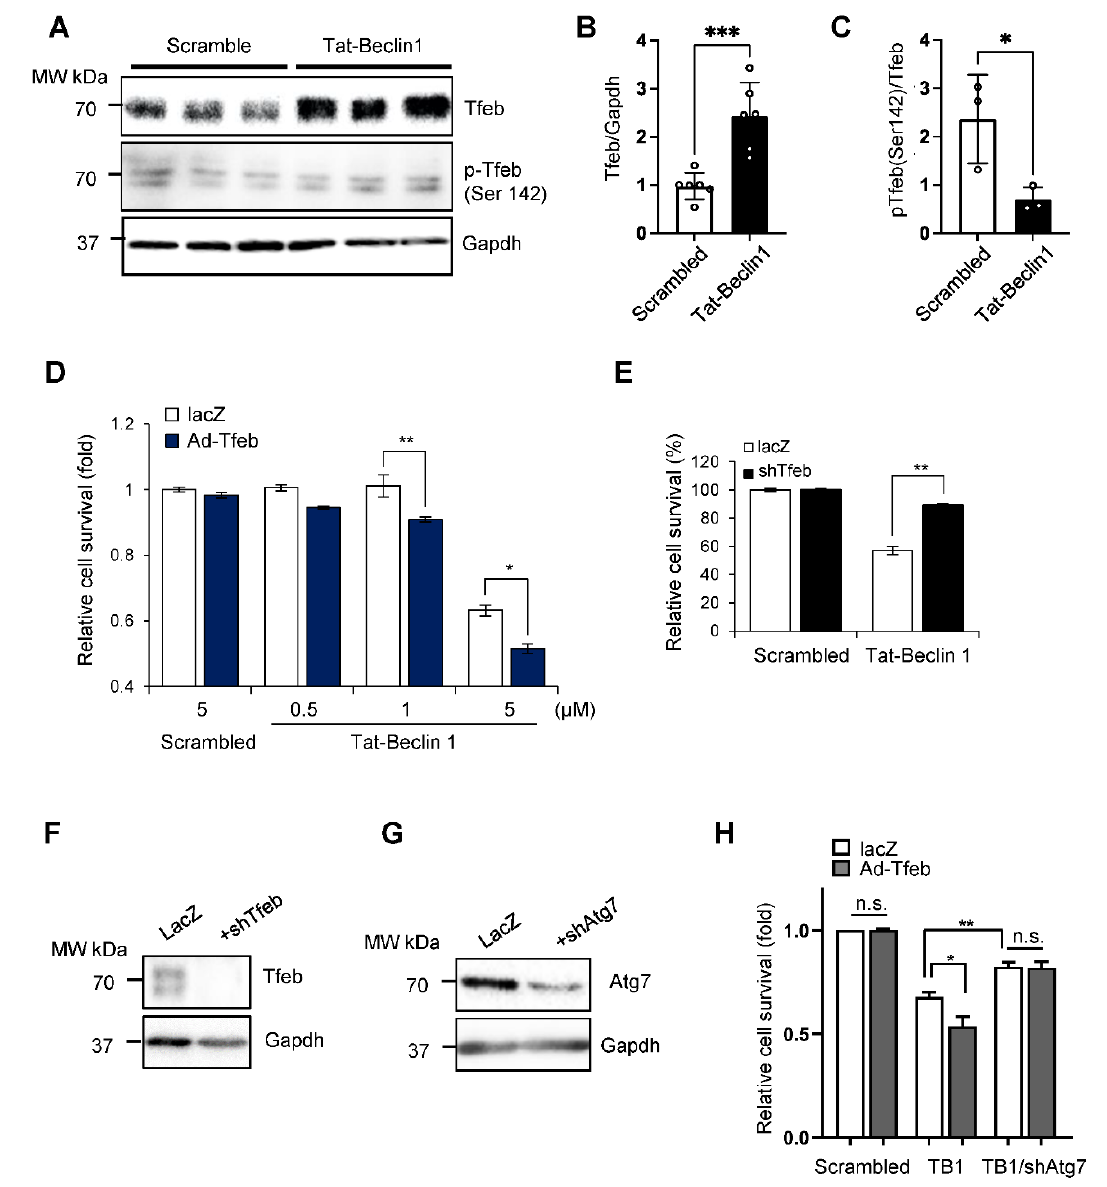
Figure 3. Tat-Beclin1-induced autosis is regulated by Tfeb modulation in NRCMs. ( A – C ) NRCMs were treated with 5 µ M Scrambled or Tat-Beclin 1 for 6 h and analyzed via Western blotting using anti-Tfeb, anti-pTfeb (Ser142) and anti-Gapdh antibodies ( A ) The relative ratios of Tfeb to Gapdh ( B ) and pTfeb to Tfeb ( C ) were quantified (mean values ±S.E., n = 6 for Tfeb, n = 3 for p-Tfeb; * p < 0.05, *** p < 0.001). ( D , E ) NRCMs were transduced with either Ad-lacZ or Ad-Tfeb for 24 h ( D ) or Ad-lacZ or Ad-shTfeb for 48 h ( E ) and then treated with 5 µM Scrambled or 0.5, 1 or 5 µM Tat-Beclin 1 for 3 h. Cell death was quantified via CellTiter-Blue assays (mean values ±S.D., n = 16; * p < 0.05, ** p < 0.01, not significant (n.s.)) ( D , E ). ( F , G ) Knockdown of Tfeb by Ad-shTfeb was confirmed via immunoblot analyses, using anti-Tfeb and anti-Gapdh antibodies ( F ). Knockdown of Atg7 by Ad-shAtg7 was confirmed via immunoblot analyses, using anti-Atg7 and anti-Gapdh antibodies ( G ). ( H ) NRCMs were transduced with either Ad-lacZ or Ad-Tfeb with or without Ad-shAtg7 as indicated for 48 h and then treated with 5 µ M Scrambled or Tat-Beclin 1 for 3 h. Cell death was quantified via CellTiter-Blue assays (mean values ±S.D., n = 16; * p < 0.05, ** p < 0.01, not significant (n.s.)).